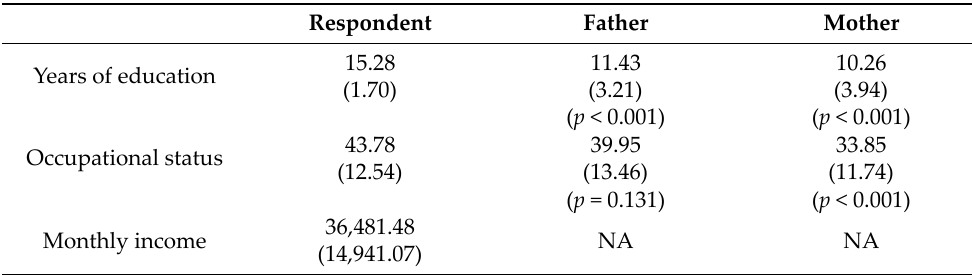
Table 3. Intergenerational comparisons of socioeconomic status.